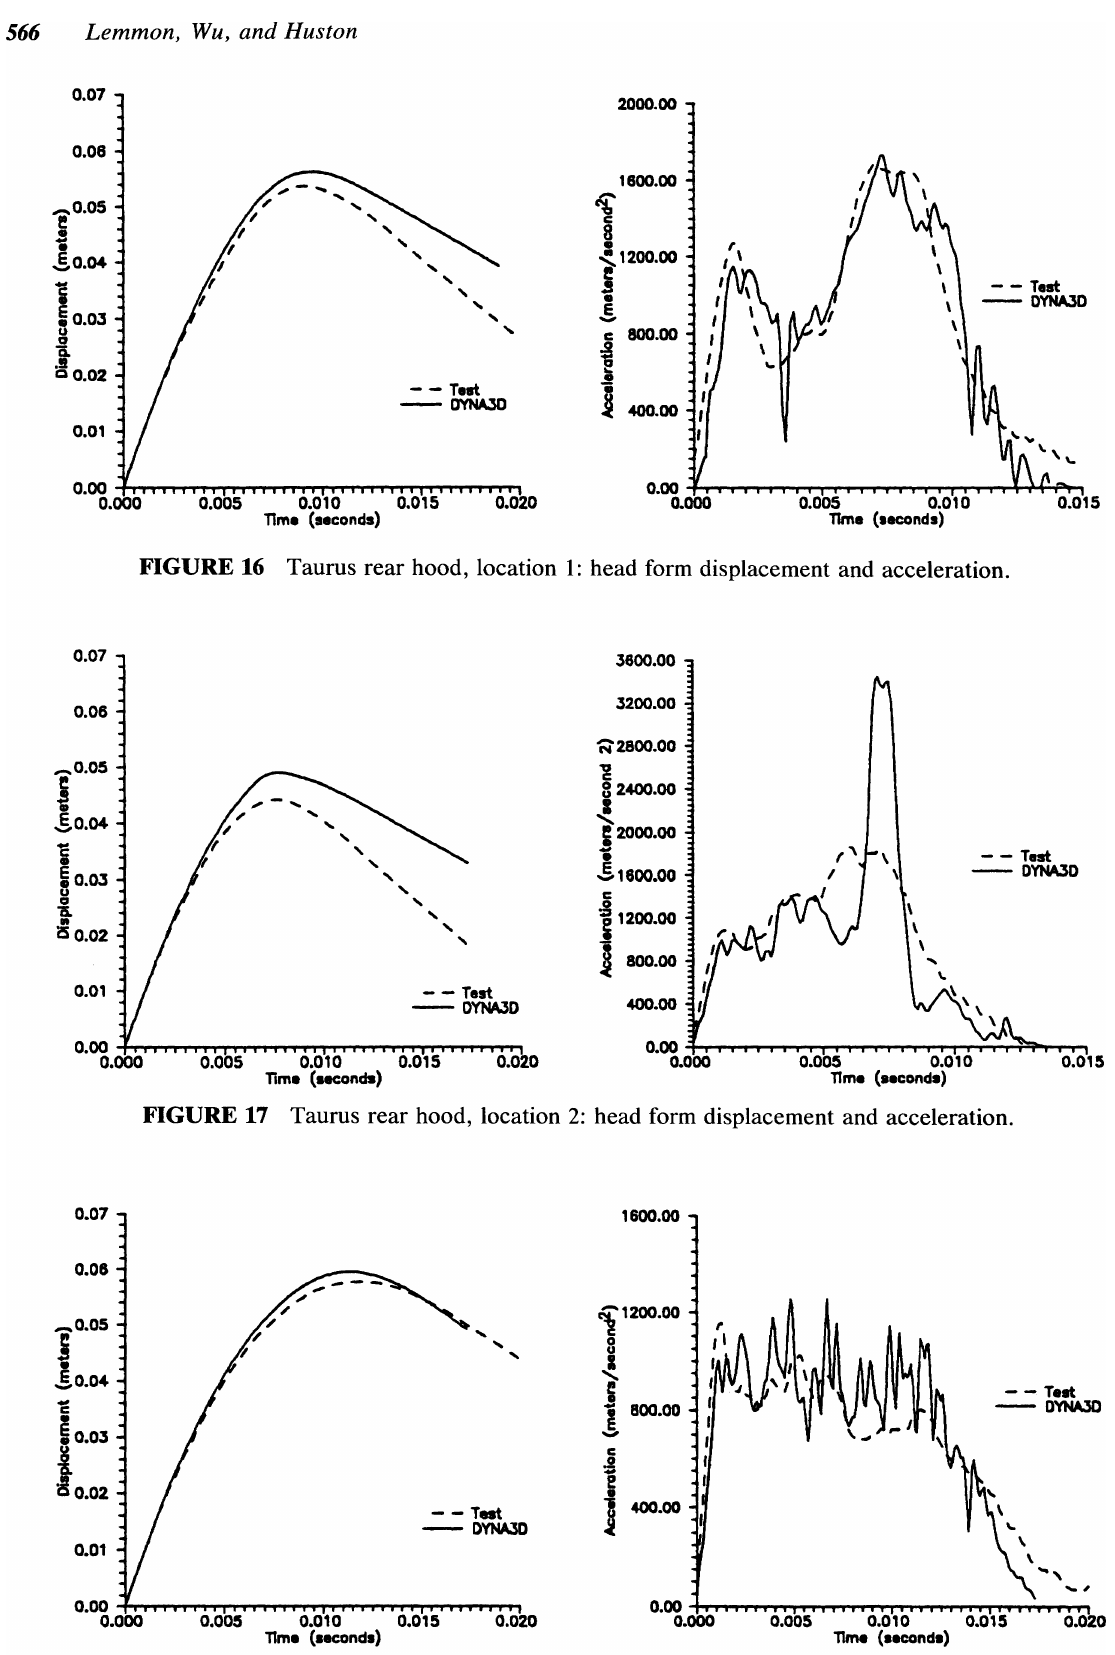
FIGURE 18 Taurus rear hood, modified fire wall: head form displacement and accelera